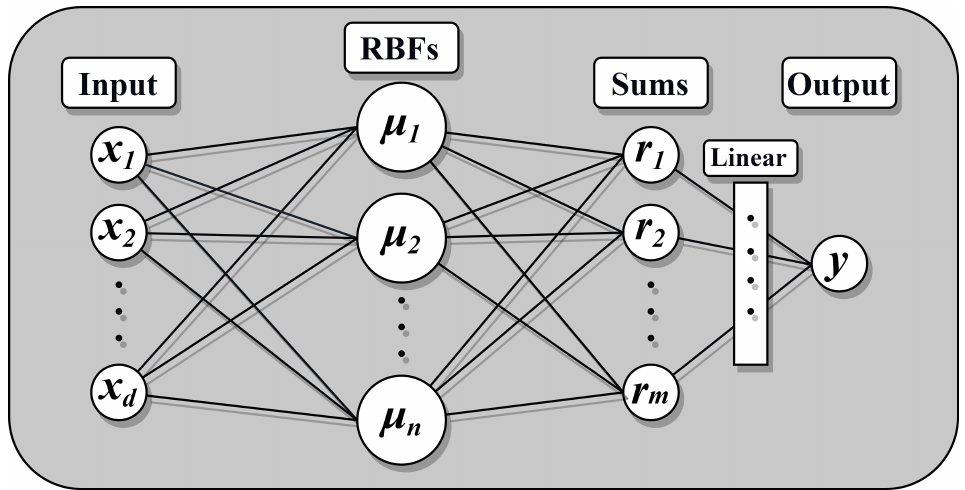
Figure 2. The structure of